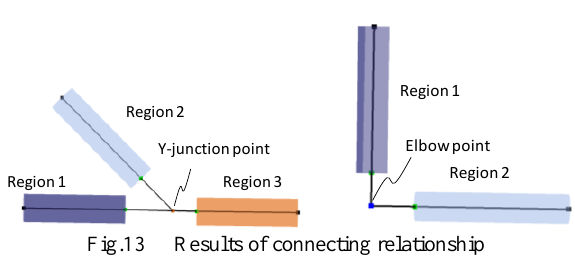
Fig.13 Results of connecting relationship